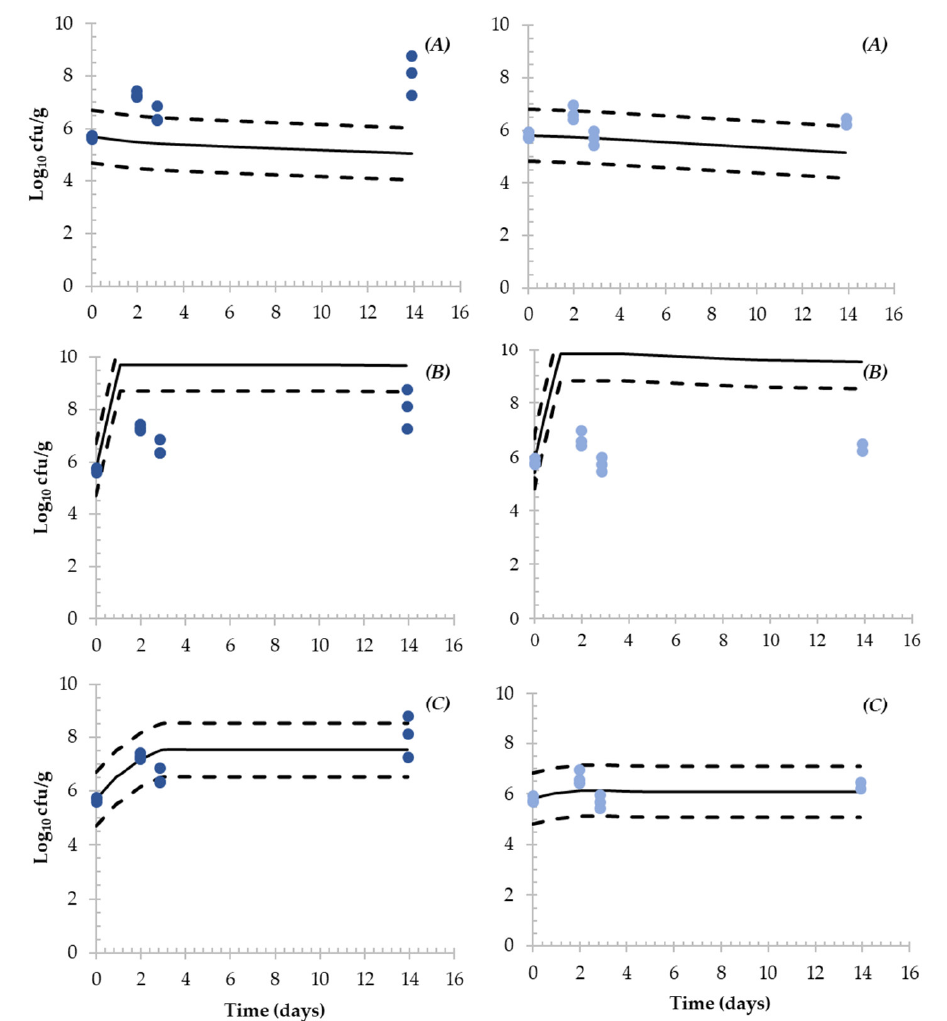
Figure 5. Simulation of Salmonella fate during the production process of snack-type DFS without ( left ) and with ( right ) starter culture. Simulations were performed in MS-Excel implementing the ( A ) Hwang et al. [30]; ( B ) Pin et al. [31] and ( C ) Coroller et al. [32] predictive models (continuous line). Dashed lines represent the acceptable simulation zone (ASZ) ± 1 Log 10 interval and dots represent the observed Salmonella counts obtained in the challenge test.